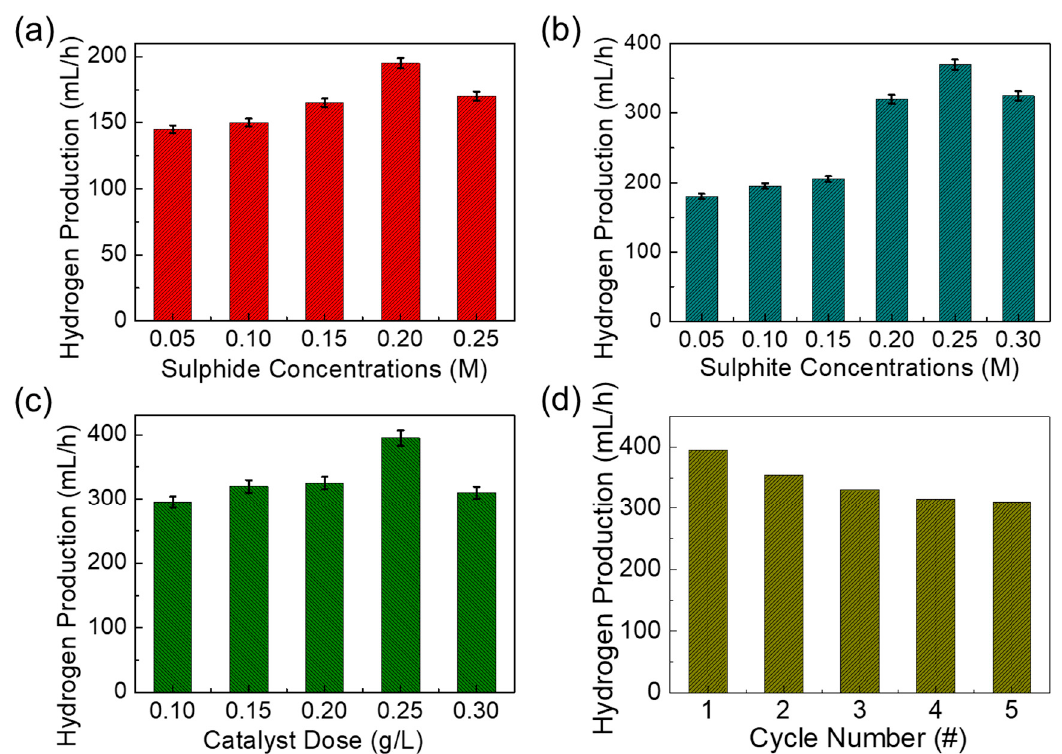
Figure 6. Hydrogen production rates of MnO 2 -AC nanocomposites as functions of ( a ) sulphite ion concentration (best value 0.2 M), ( b ) sulphide ion concentration (best value 0.25 M), ( c ) catalyst dose (best value 0.25 g / L), and ( d ) cycle number of photocatalytic reaction.